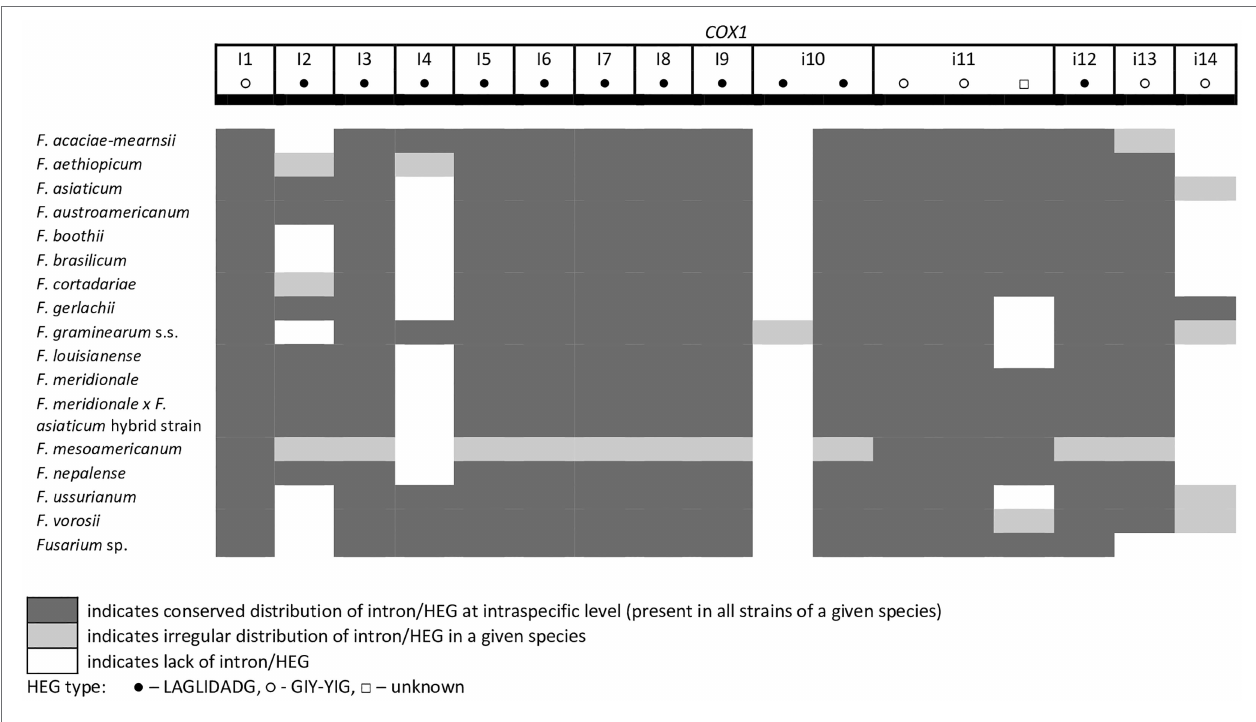
FIGURE 2 | Distribution of introns and associated HEGs found in the COX1 gene.